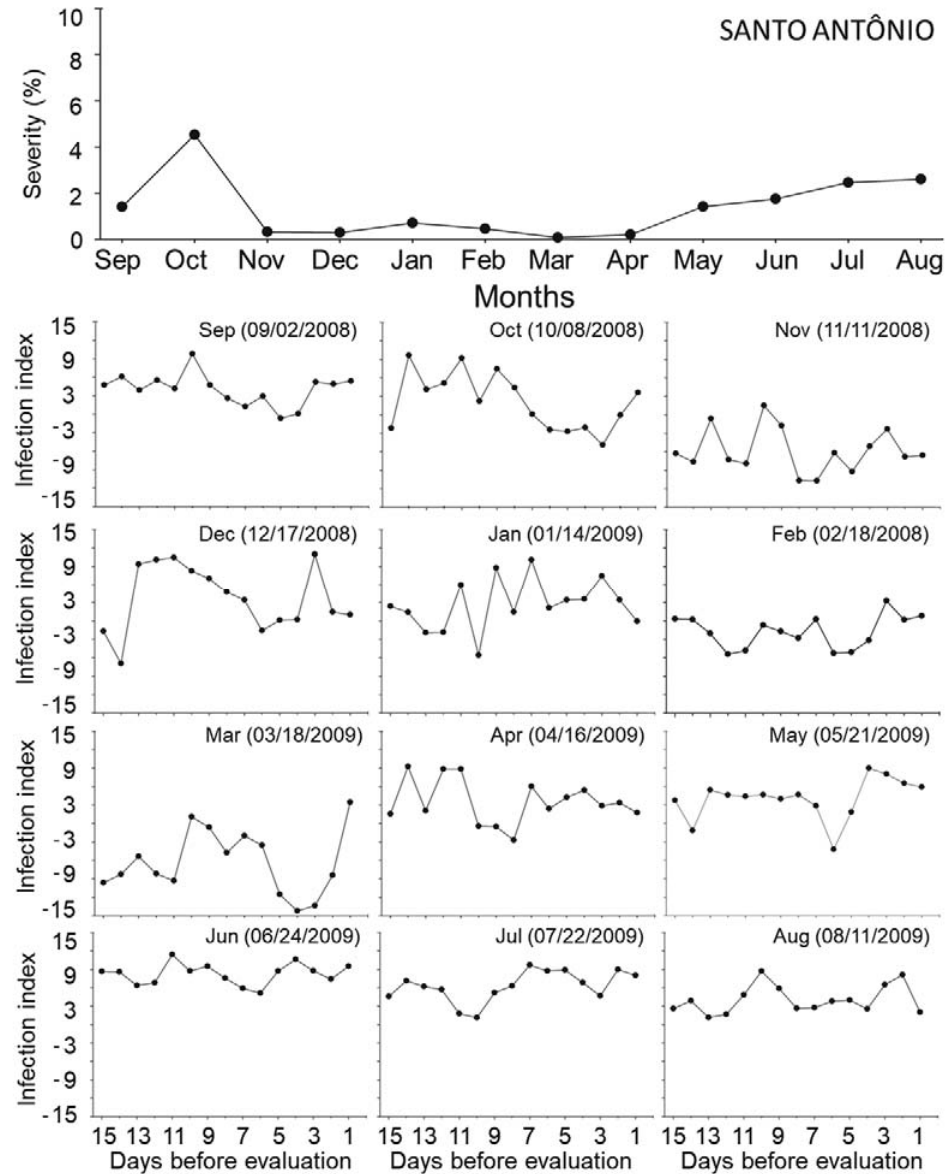
Figure 10. Eucalyptus rust severity (%) and infection index was evaluated under field conditions and used to calculate the infection according to the equation by [11], for the 15 ‐ day period prior to our monthly evaluations conducted from September 2008 through August 2009, in the municipality of Santo Antônio, located in the extreme south of Bahia,